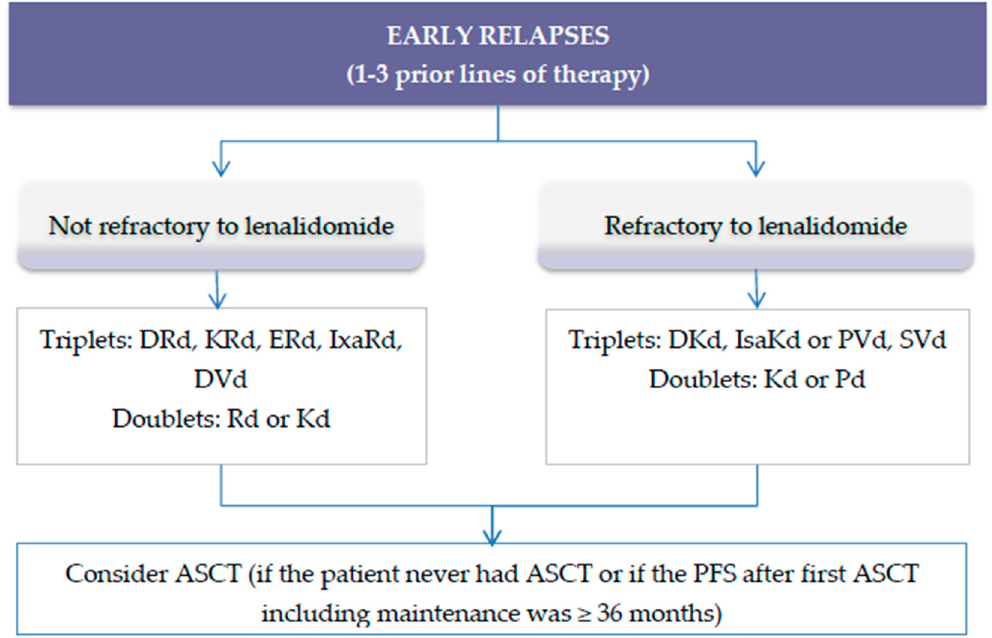
Figure 2. Suggested algorithm to treat patients with RRMM and 1 − 3 prior lines of therapy.